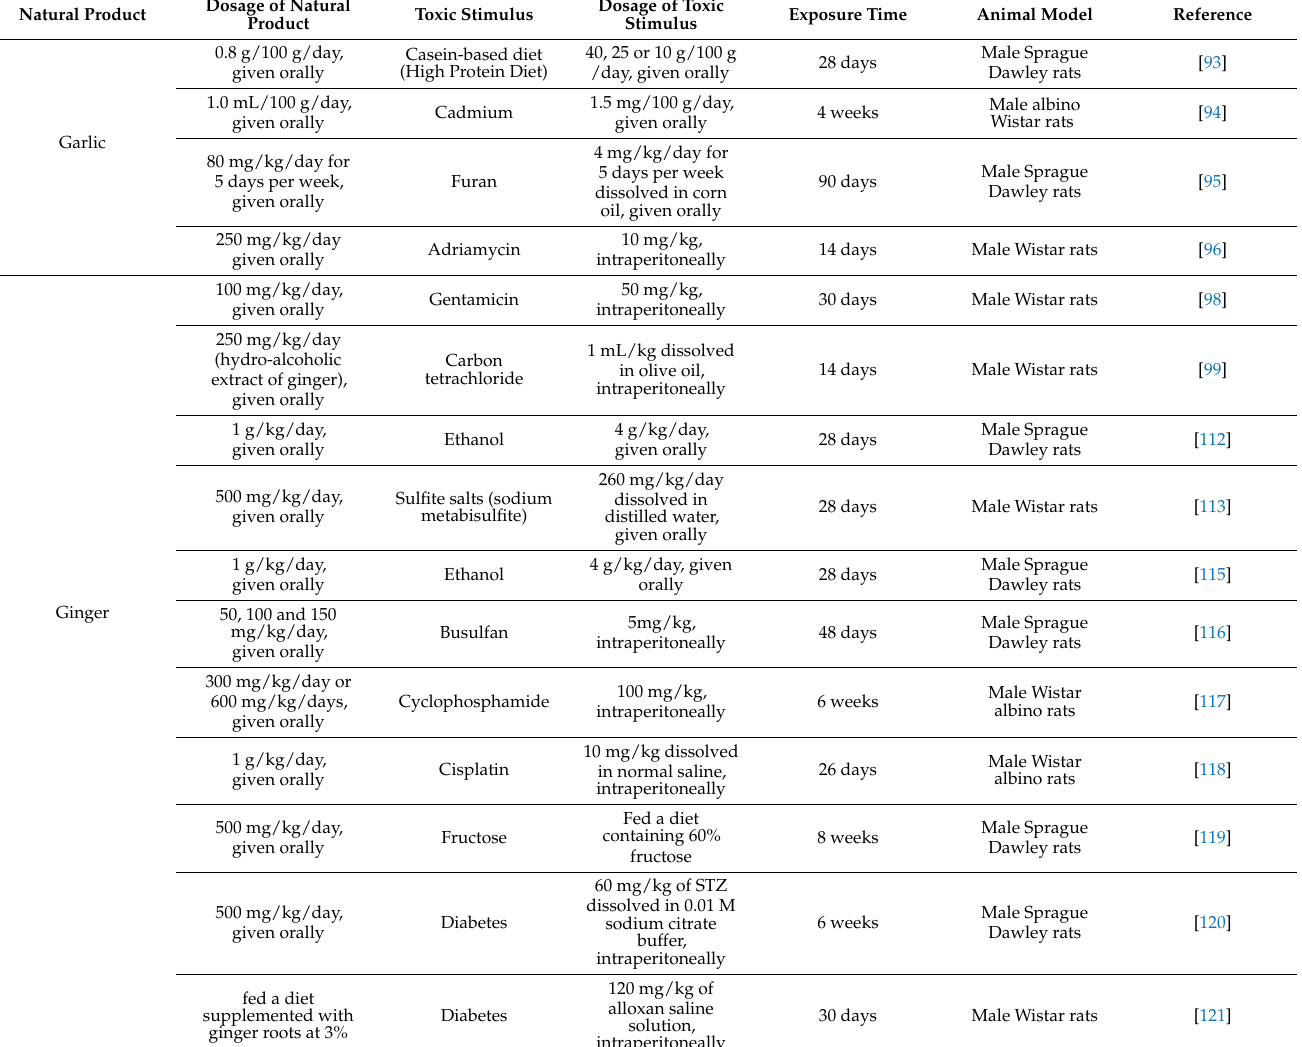
Table 2. Bioactive compounds present in natural products with beneficial effects in male reproductive system. Natural Product Dosage of Natural Product Toxic Stimulus Dosage of Toxic Stimulus Exposure Time Animal Model